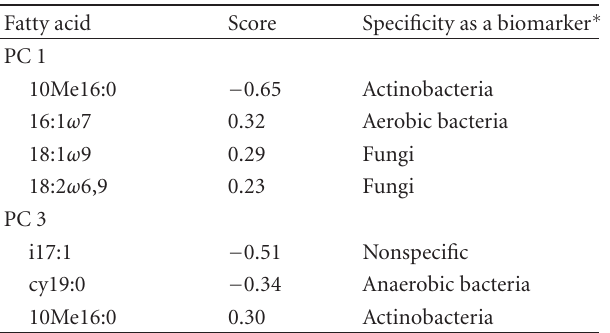
Table 3: PLFA having scores > |± 0 . 23 | for the first and third prin- cipal components.